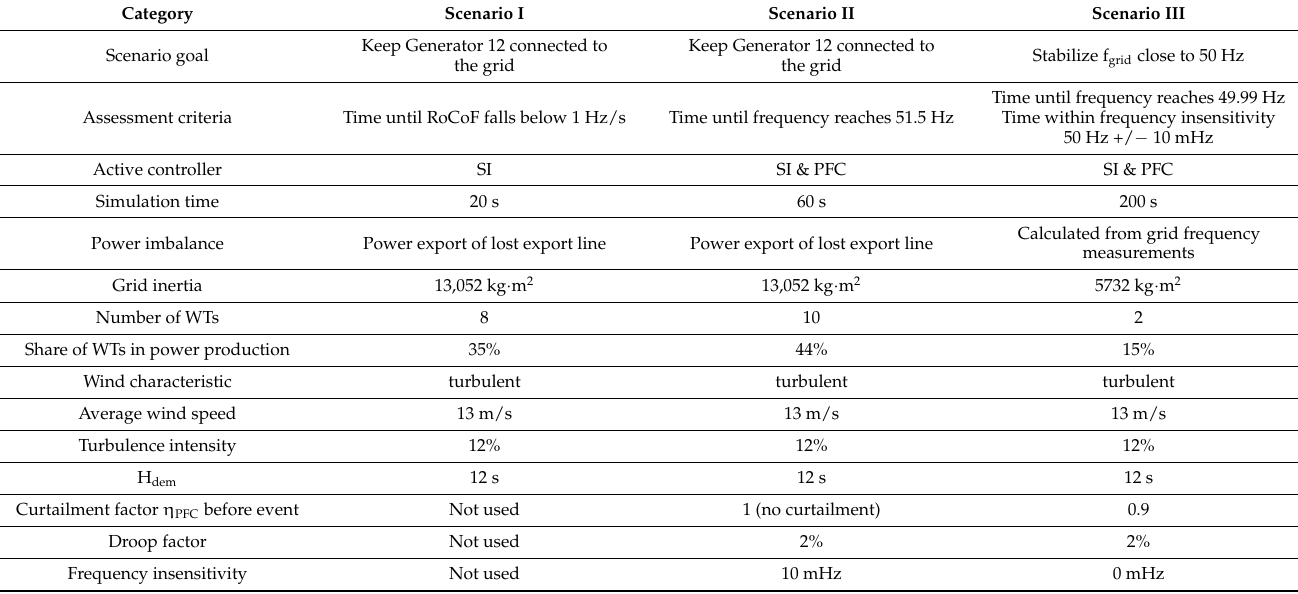
Table 2. Overview of simulated scenarios and the used simulation and controller